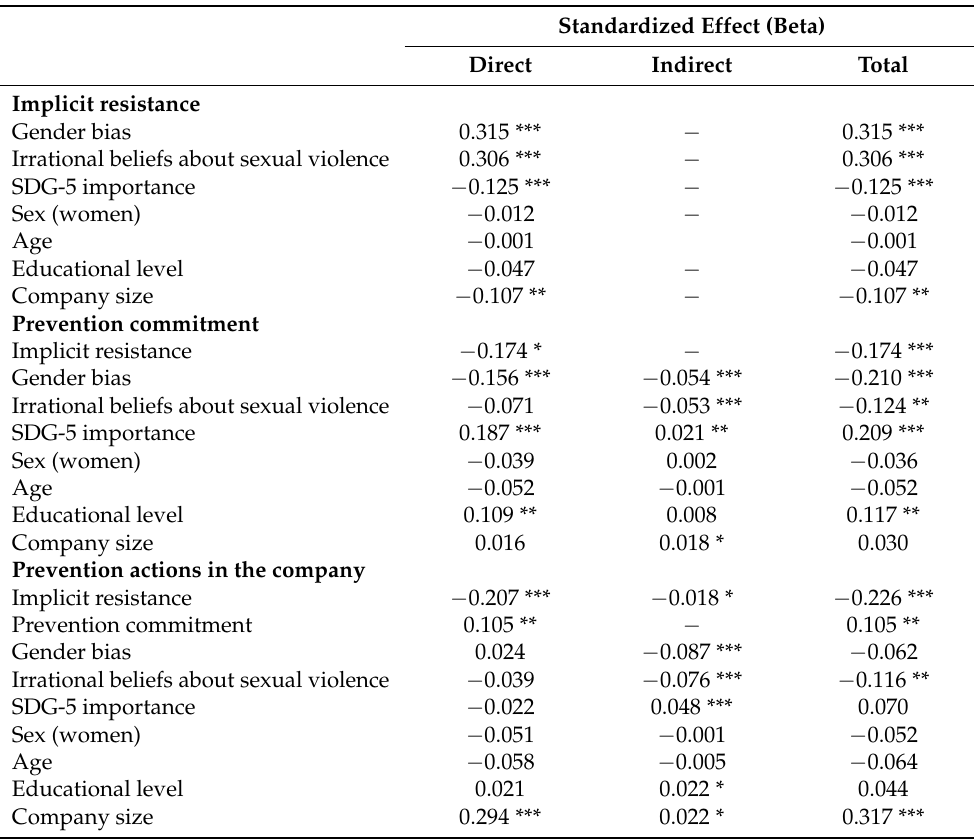
Table 7. Effects of implicit resistance on the commitment and actions to prevent gender violence in companies, controlling for sex, age, educational level, and company